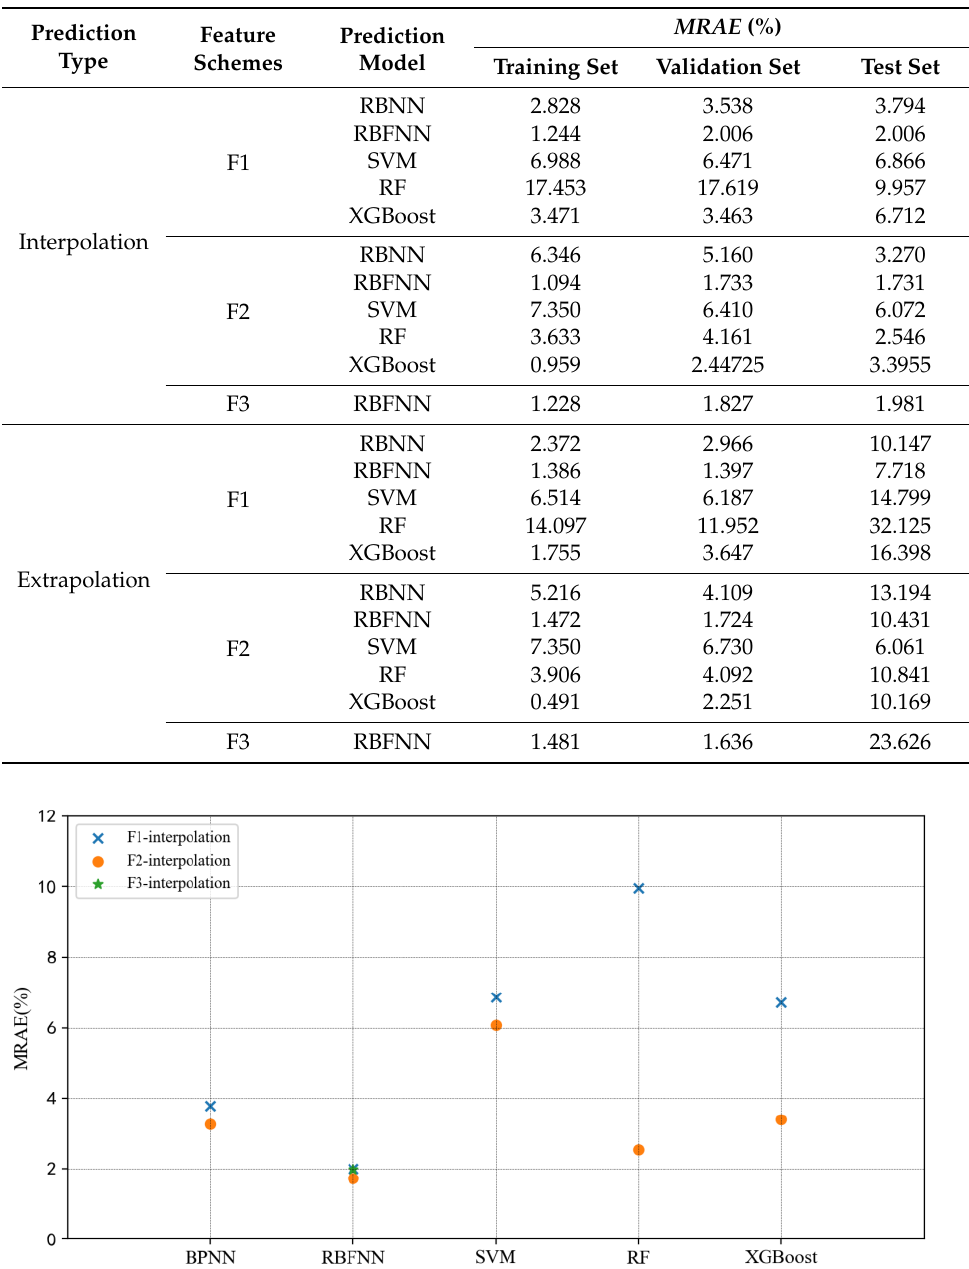
Table 10. The prediction results of different models.